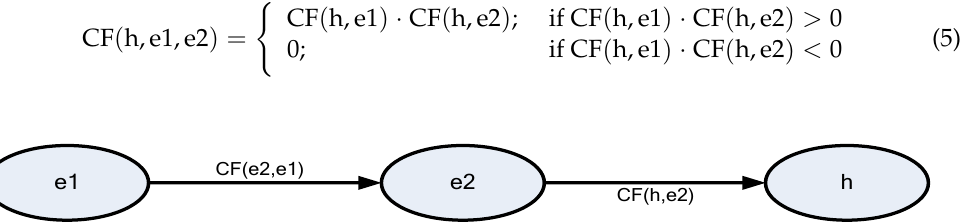
Figure 5. Result of simplification based on Formulas (4) or (5) (the authors’ own study based on [2]). The source literature often contains an incorrect interval ( − 1.1). However, based on For- mula (3), the range of variables used in this model is determined by the interval < − 1.1>. 1 in- dicates the full certainty of the studied hypothesis, and − 1 means its negation. 0 indicates the lack of premises related to the studied hypothesis. When analysing Equations (2) and (3), one can notice that the values of interval extremes cannot be taken into account as model functionality would not be satisfied. 4. Calculation and Demonstration In order to demonstrate the method’s effectiveness, the project authors selected an intersection traffic light system as an example. At this intersection, the no-entry rule is frequently v iolated when the red light is lit. A photographic view from a driver’s position is shown in Figure 6. Figure 7 presents a photograph with the probable element that dis- turbs the correct interpretation of the intersection’s lighting system state. Pictures ha ve been taken from the car travel registration because we would like to show how this scene looks from the driver’s position. It is a red -coloured glowing roadside advertisement. The blue oval indicates this red roadside advertisement in both pictures in Figures 6 and 7. The model describing the object will consist of two last information states, forwarding and interpretation. Information transfer redundancy (double traffic lights at the intersection) was conducted in this case. Two cases were considered: Forwarding information without redundancy (Figure 8), Forwarding information with redundancy (Figure 9).